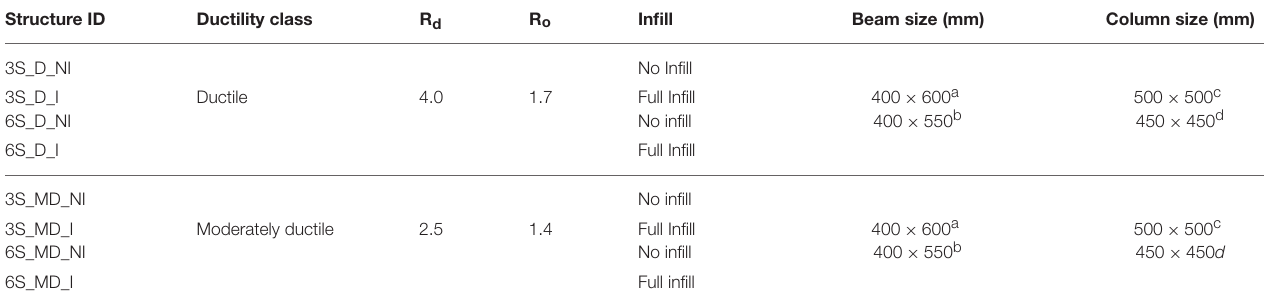
TABLE 1 | Summary of design characteristic of Ductile and Moderately Ductile RC frame. Structure ID